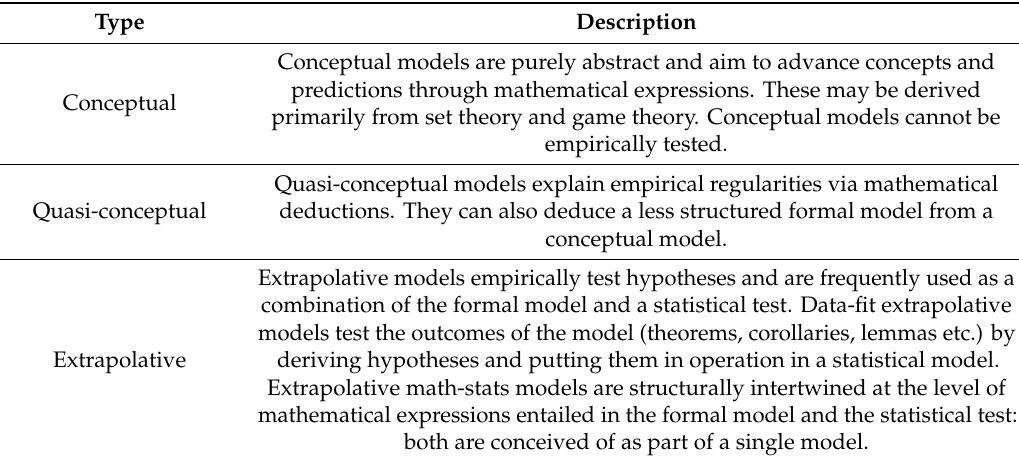
Table 1. A taxonomy of models in political